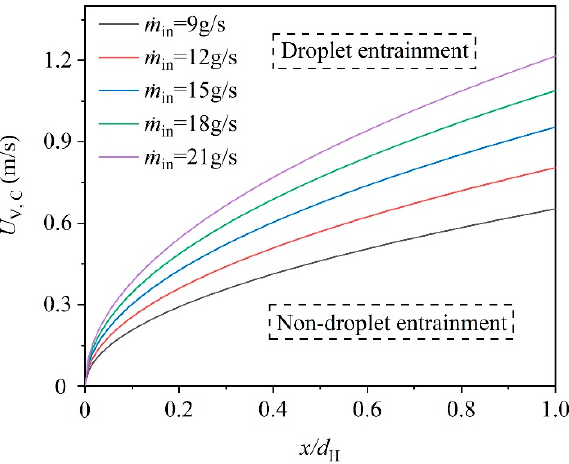
Figure 12. The critical vapor velocity with and without vortex under various ṁ